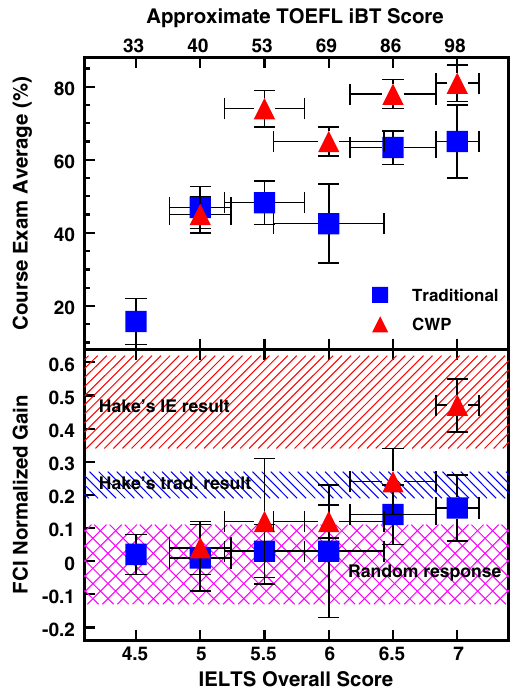
FIG. 4. Course exam averages (top) and FCI normalized gains (bottom) plotted versus language proficiency, as measured by IELTS overall score (bottom horizontal axis). Vertical error bars are standard errors in the mean for these data. An approximate TOEFL iBT score adapted from Table 7 of Ref. [14] and displayed (top horizontal axis). Horizontal error bars are ap- proximated by a linear fit ( R ¼ 0 . 978 ) to this table [14] and do not necessarily represent the uncertainty in student language proficiency, but rather the relative uncertainty between IELTS and TOEFL iBT scales. For FCI normalized gains (bottom), Hake ’ s result [16] for the average and standard error interval for tradi- tional (blue, left-hatched) and IE (red, right-hatched) pedagogy are highlighted. The average and standard error interval for random responses (purple, cross-hatched) is highlighted for benchmarking